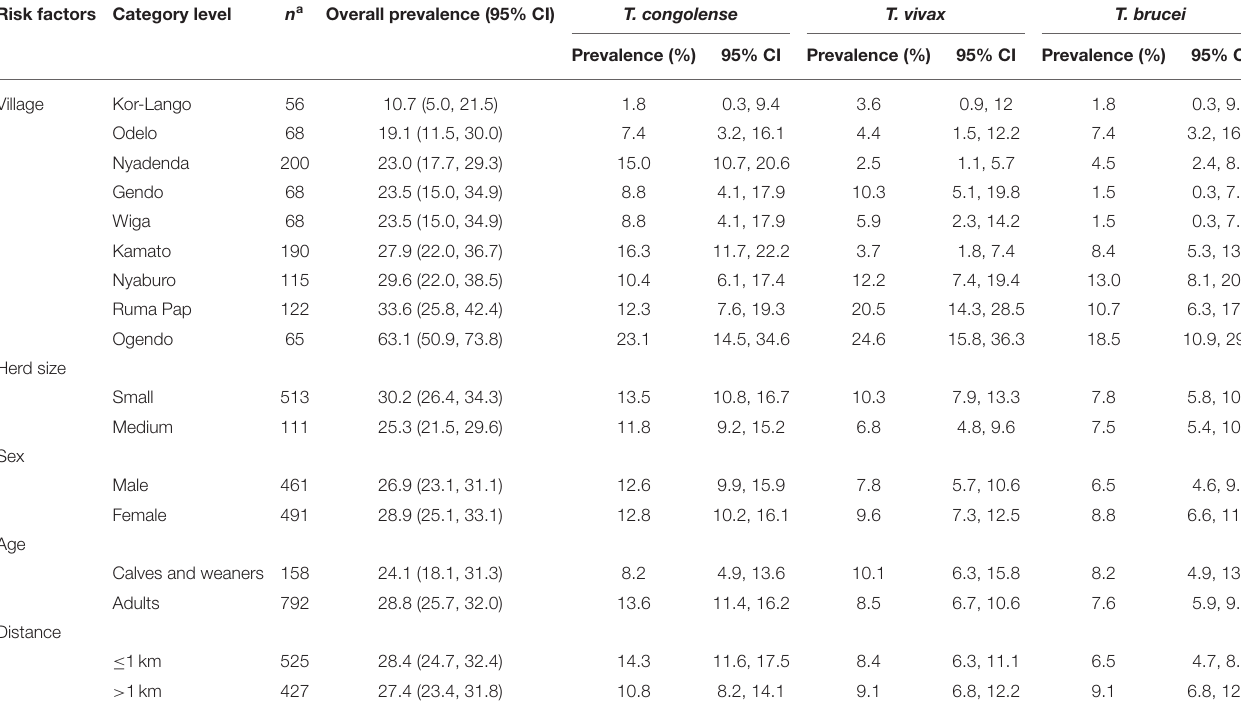
TABLE 4 | Risk factors associated with trypanosome infection status using PCR-HRM as a reference test. Risk factors Category